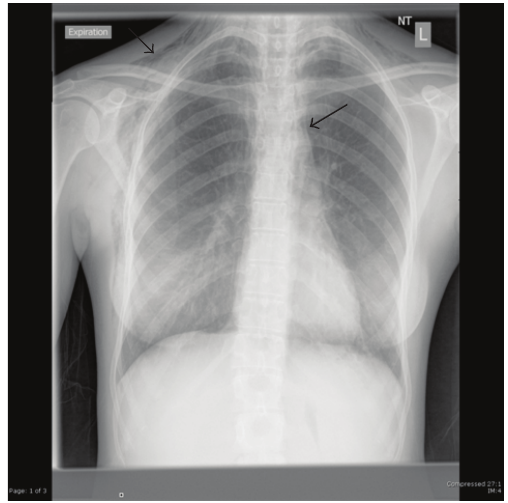
Figure 1: Left pneumomediastinum and subcutaneous emphysema in patient